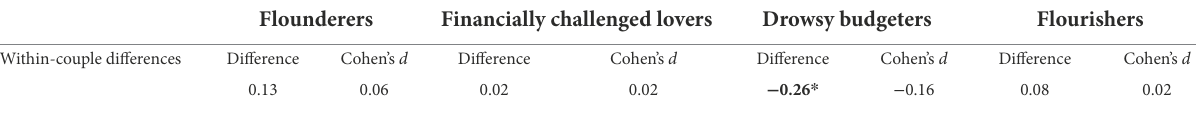
TABLE 5 Difference scores between Husbands’ and Wives’ marital satisfaction across the latent profiles (N = 1,001